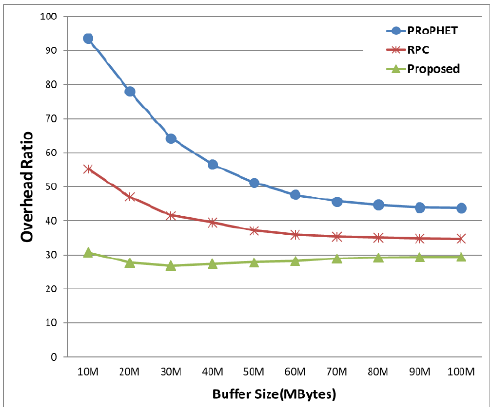
Figure 6. Overhead ratio for different buffer sizes.